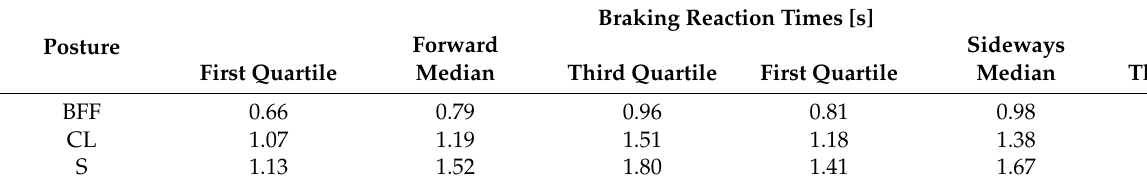
Table 4. Quartile table of brake reaction times.